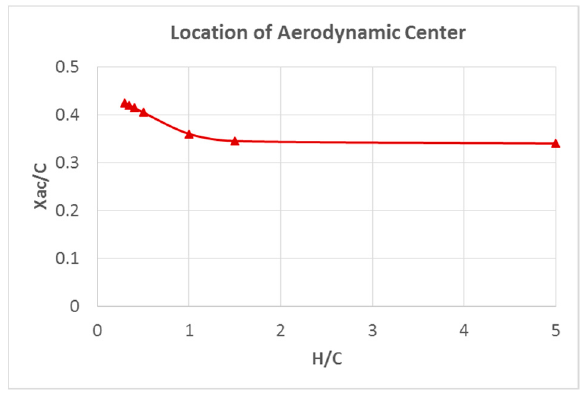
Figure 6. Effect of H/C to the Aerodynamic